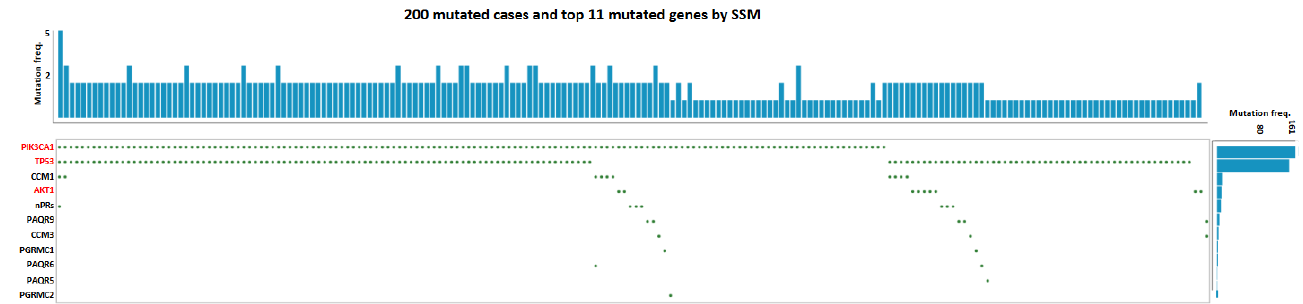
Figure 1. Oncogrid analysis of simple somatic mutations in known breast cancer oncogenes and key genes within the CmPn signaling network. Known driver oncogenes (red colored) and key components (black colored) of the CmPn signaling network from 200 breast cancer lesions in Genomic Data Commons (GDC) and The Cancer Genome Atlas ( TCGA ). Utilizing the GDC data portal from the National Cancer Institute (NCI), the distribution of simple somatic mutations (SSM) for breast cancer lesions for common breast cancer driver genes, along with SSM counted in all key CmPn players were assessed. SSM, represented with green dots, are somatic mutations that include single base substitutions, small deletions, and insertions (<= 200 bp).